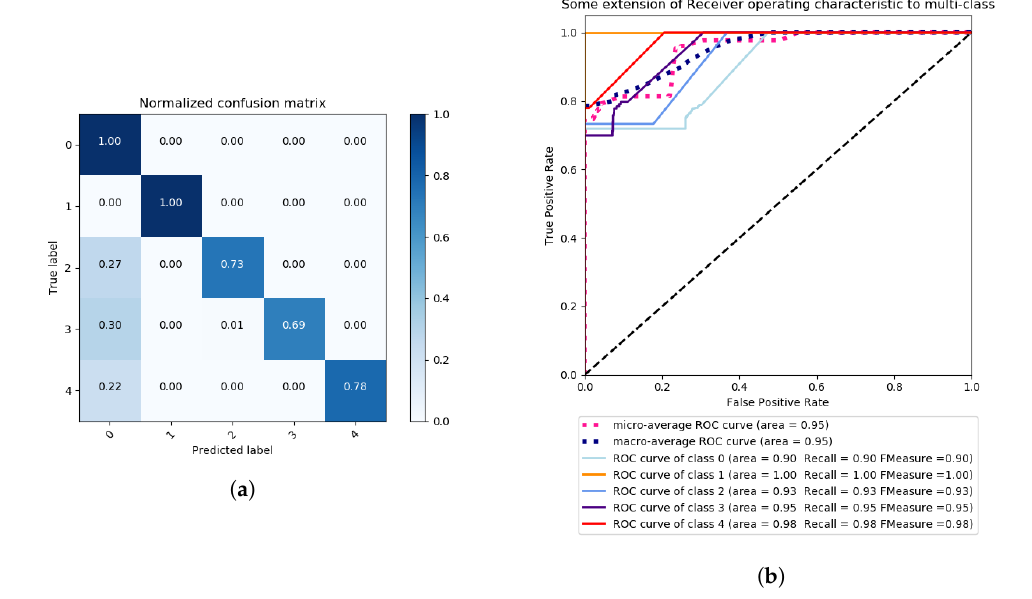
Figure 7. Multi-class problem—Grid Search SVM with polynomial Kernel, One vs. Rest decision function shape, 30 iterations, and scoring criterion of accuracy, Confusion Matrix ( a ) and ROC Curves ( b